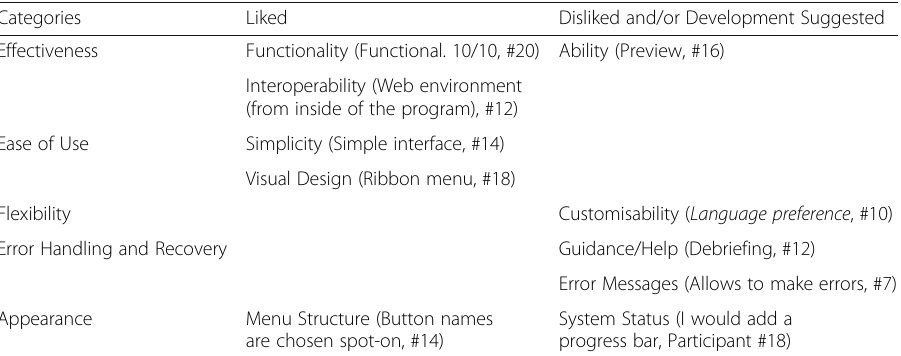
Table 5 Categories and related patterns